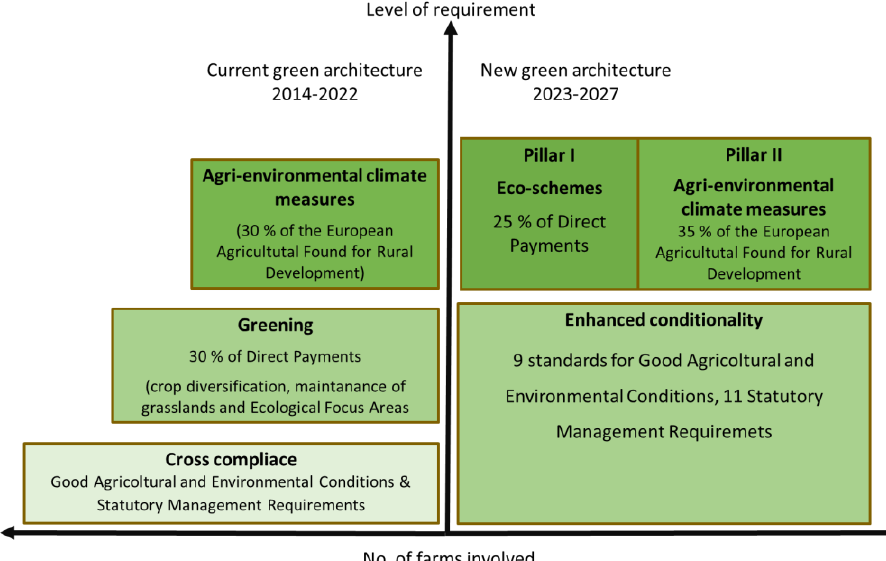
Figure 1. The new Green Architecture of the CAP. Source: own adaptation from European Commis- sion, DG Agriculture and Rural Development.